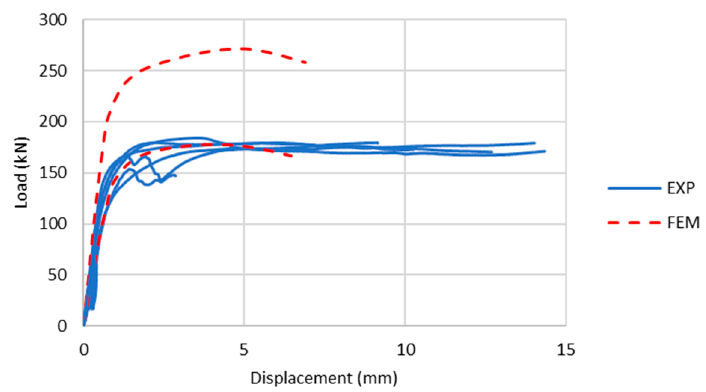
Figure 18. Load-displacement curves comparison between experimental and FEM of series I.